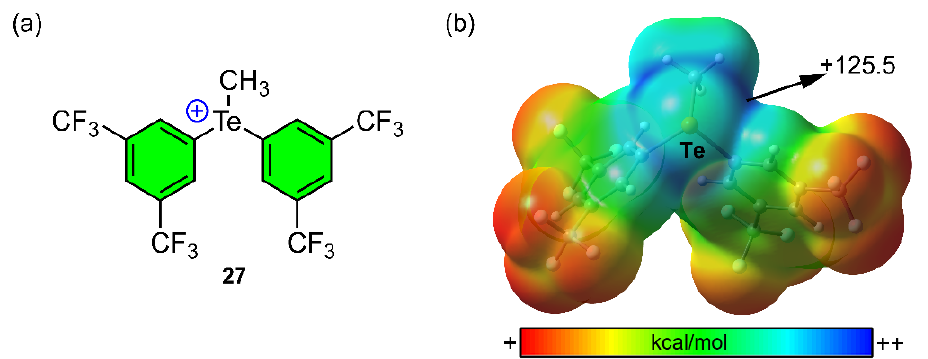
Figure 19. ( a ) Schematic view of compound 27 and ( b ) MEP surface of the catalyst at the B3LYP/def2- TZVP level of theory. Energy value in kcal/mol (0.001 a.u.).